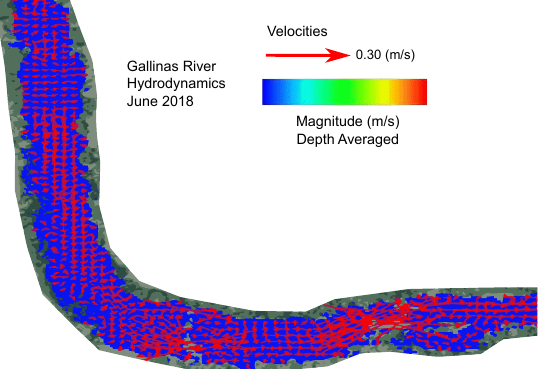
Figure 10. Velocity fields in a section of the model, 6 June 2018, at 21:10 h. The change in magnitudes due to the variation in the width of the section as well as the presence of waterfalls along the riverbed can be observed. Image generated using EFDC